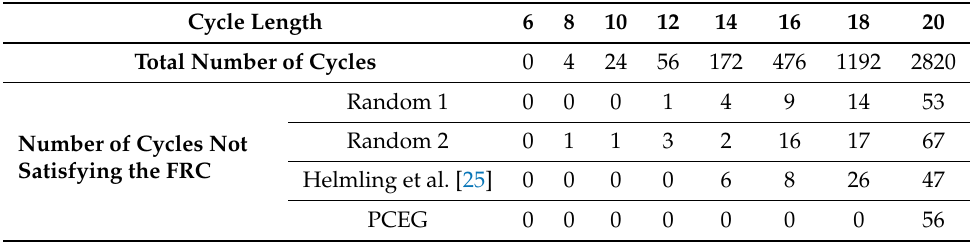
Table 3. Cycle distributions of NB-LDPC codes over GF(64) with the code length of 576 bits and the code rate of 1/2.